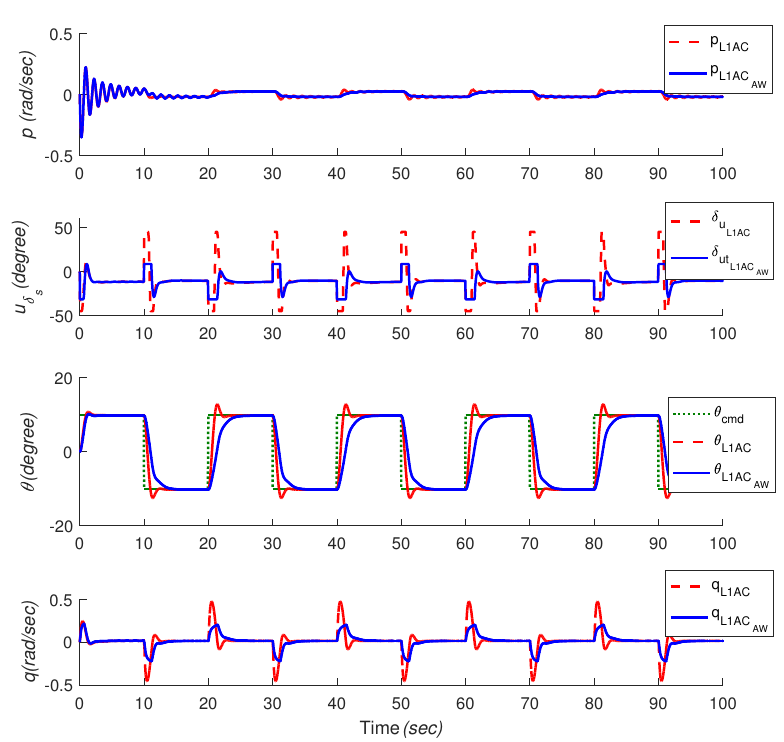
Figure 6. Pitch channel control in the presence of the actuator saturation for REMUS six DOF model tracking θ cmd (pulse signal).